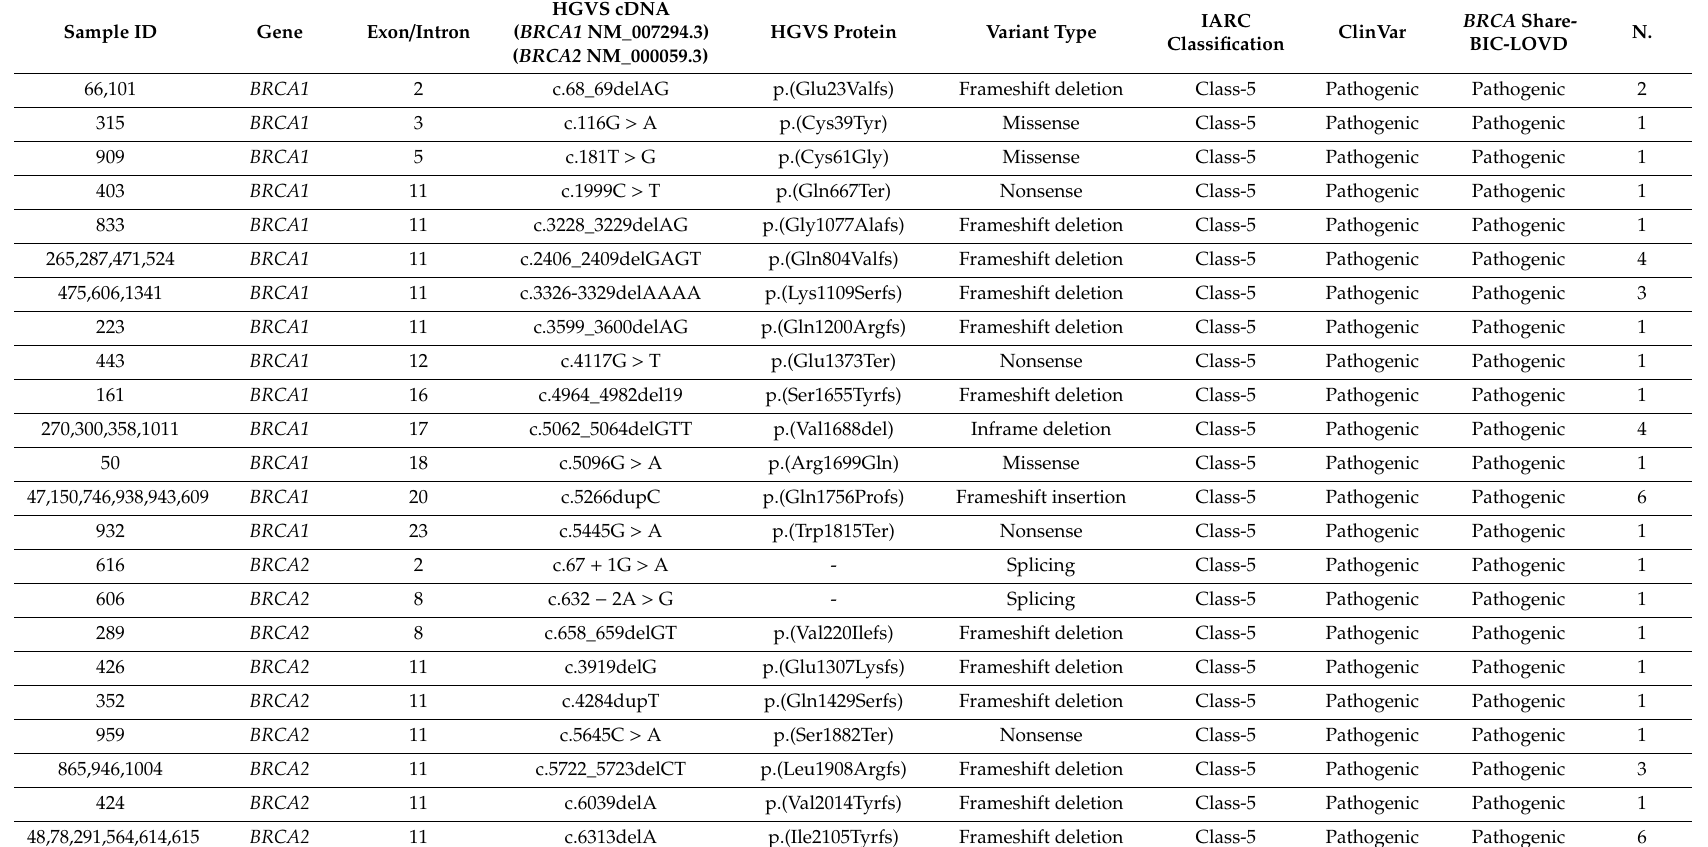
Table 2. (A) List of BRCA1 and BRCA2 pathogenic / likely pathogenic variants detected in 50 Central Italian individuals. (B) List of BRCA1 and BRCA2 Variants of Uncertain Significance (VUS) variants detected in 33 Central Italian individuals *. Table 2 (A) List of BRCA1 and BRCA2 Pathogenic / Likely-Pathogenic Variants Detected on 50 Central Italian